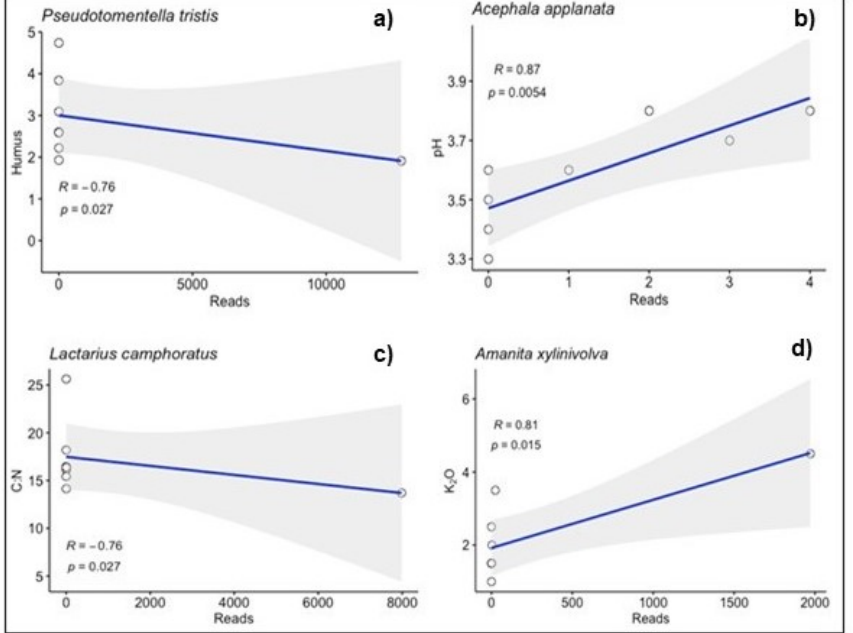
Figure 5. Examples of correlations between selected fungal species ( Pseudotomentella tristis ( a ), Acephala applanate ( b ), Lactarius camphoratus ( c ), Amanita xylinivolva ( d )) and soil parameters.